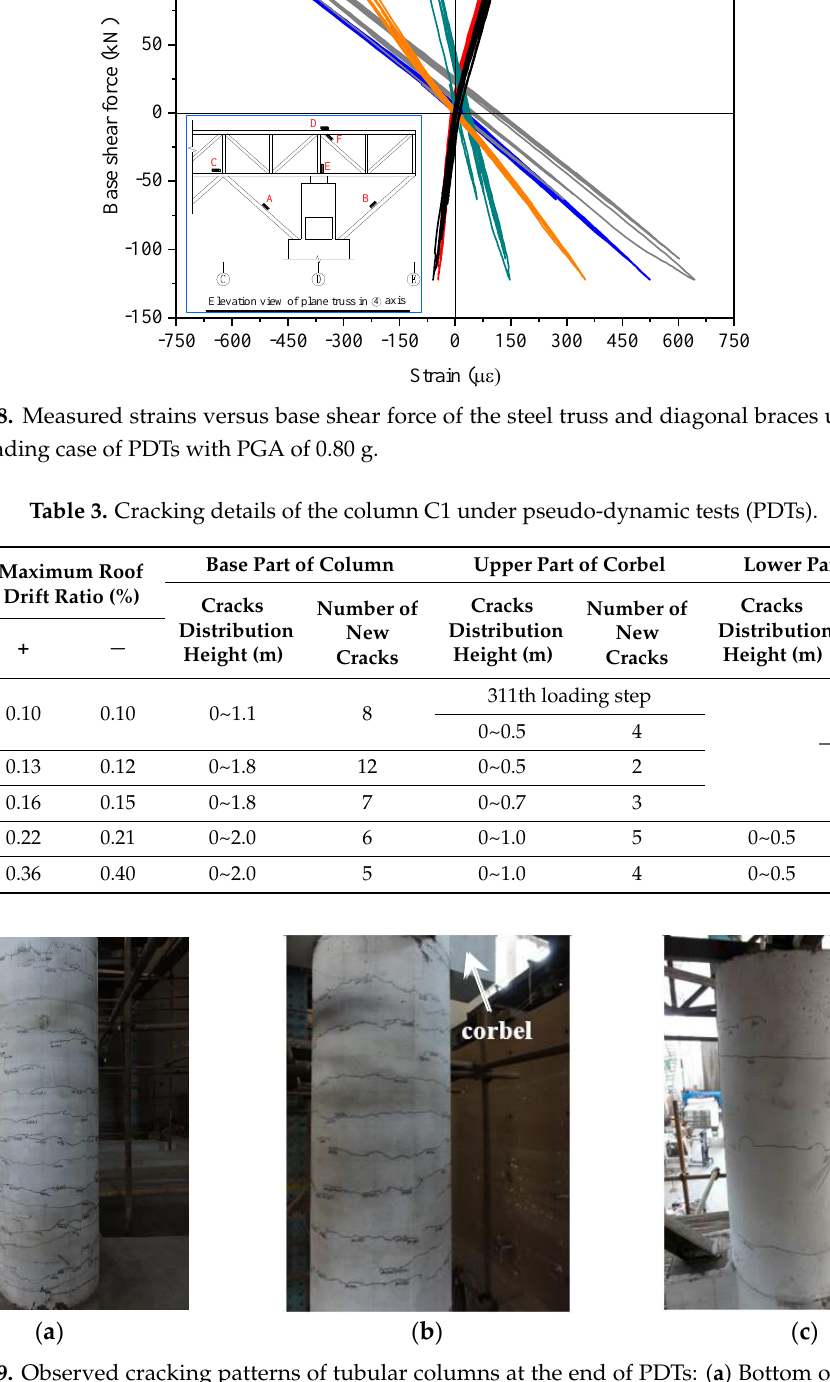
Table 3. Cracking details of the column C1 under pseudo-dynamic tests (PDTs).